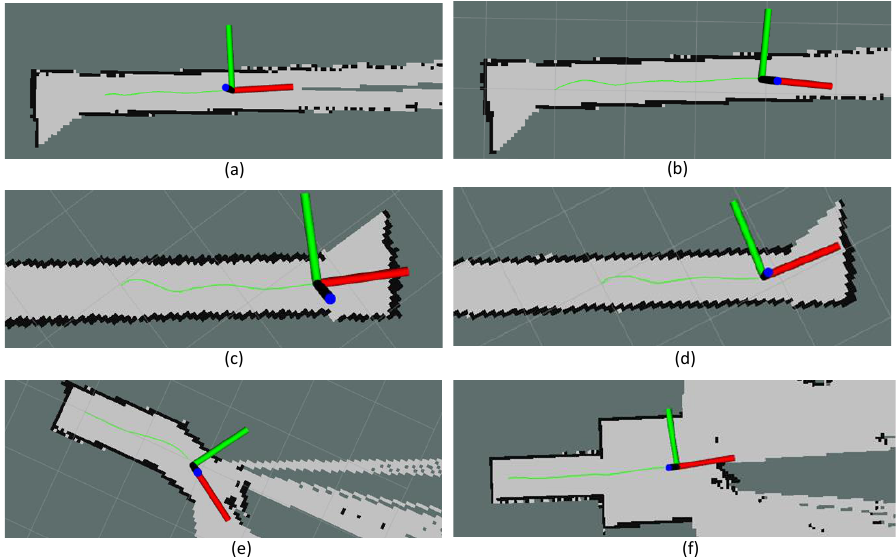
Figure 14. Traced path of the robot during the test scenarios. ( a ) Scenario ‘a’, ( b ) Scenario ‘b’, ( c ) Scenario ‘c’, ( d ) Scenario ‘d’, ( e ) Scenario ‘e’, and ( f ) Scenario